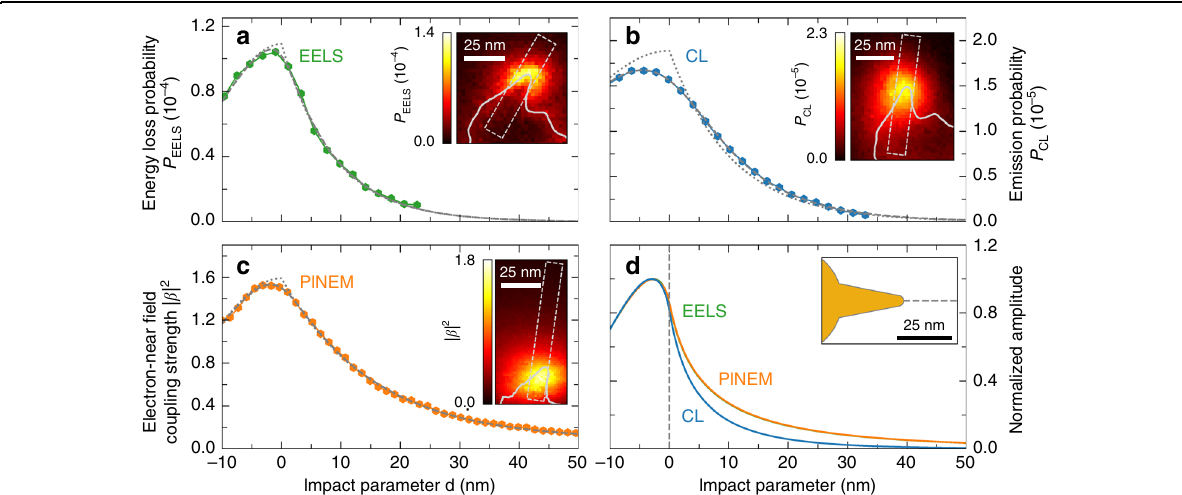
Fig. 5 EELS, CL, and PINEM amplitude pro fi les. Intensity pro fi les through a 200 keV EELS (1.68 eV), b 20 keV CL (1.72 eV), and c 200 keV PINEM ( (cid:1) h ω L = 1.55 eV photon energy) distributions along the symmetry axis of tip II. We also plot model fi ts assuming Gaussian broadening of the data due to the fi nite width of the electron beam (dashed curves) and deconvoluted model functions (dotted curves). An impact parameter of d = 0 corresponds to the approximate position of the tip apex derived from the fi tting procedure. d BEM calculations of 200 keV EELS (green, hidden behind the PINEM curve), 20 keV CL (blue), and 200 keV PINEM (orange curve) pro fi les along the tip symmetry axis of the model geometry. The calculated pro fi les are normalized to their respective amplitudes at the tip apex. As in the experiments, EELS and CL probabilities are calculated for a spectral bandwidth of ±25 meV around the tip resonance at 1.73 eV, while the PINEM interaction strength is calculated for laser polarization along the symmetry axis of the tip at an excitation energy of (cid:1) h ω L = 1.73